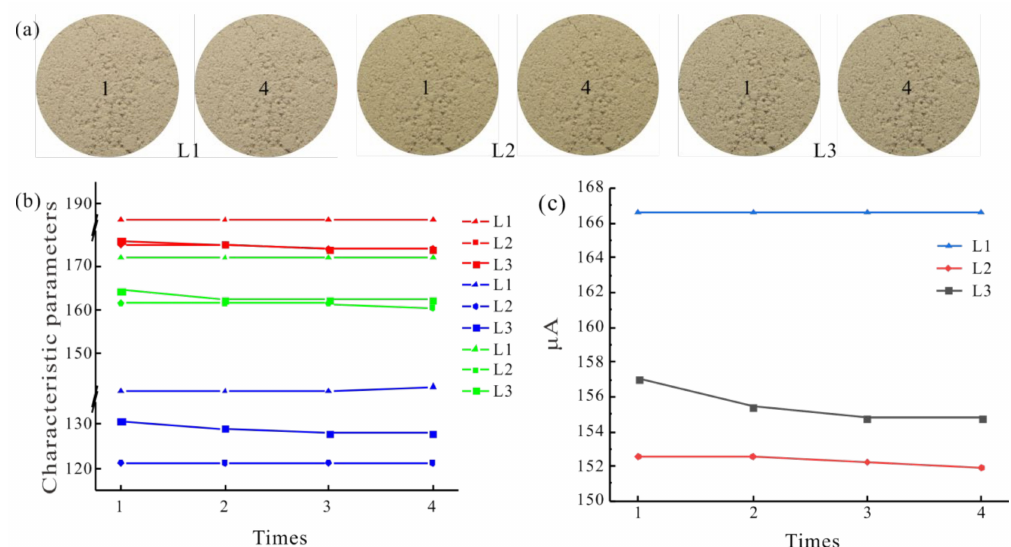
Figure 8. Characteristic parameters change of Soil 1b image at different times: ( a ) original images;